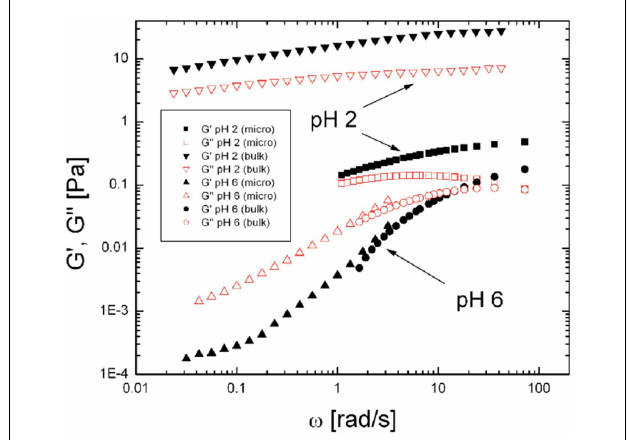
FIGURE 5 | Comparison of viscoelastic moduli, G (cid:48) ( ω ) and G (cid:48)(cid:48) ( ω ) for PGM at pH 2 and pH 6 probed by bulk rheology and particle tracking microrheology . In the solution state (pH 6 PGM) bulk and microrheology measurements of both components, G (cid:48) ( ω ) and G (cid:48)(cid:48) ( ω ) (labeled as indicated in the Figure) are in agreement over the frequency range accessible. In contrast, the viscoelastic moduli obtained by bulk and microrheology differ significantly in the gel phase (pH 2) suggesting the presence of microstructural heterogeneity and length-scale dependent rheology in the gel state. Reproduced from Celli (80) with permission of